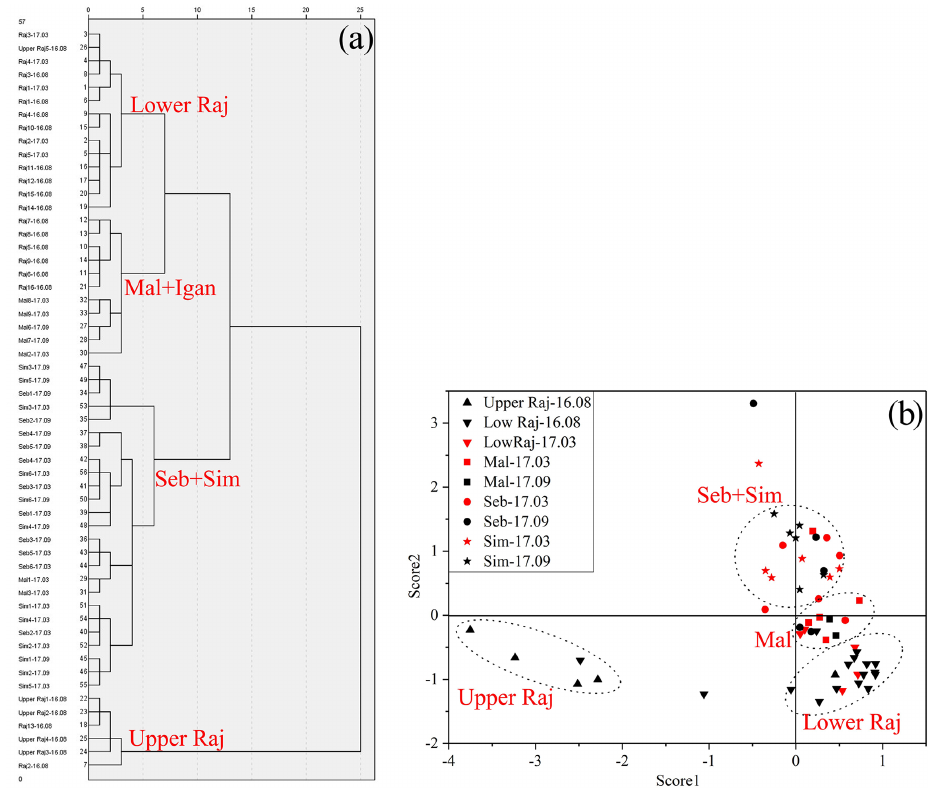
Figure 3. (a) Cluster analysis of the studied systems based on bulk and lignin phenol parameters. (b) Plot of PCA results based on the distribution of scores 1 and 2. Raj: Rajang; Seb: Sebuyau; Sim: Simunjan; Mal: